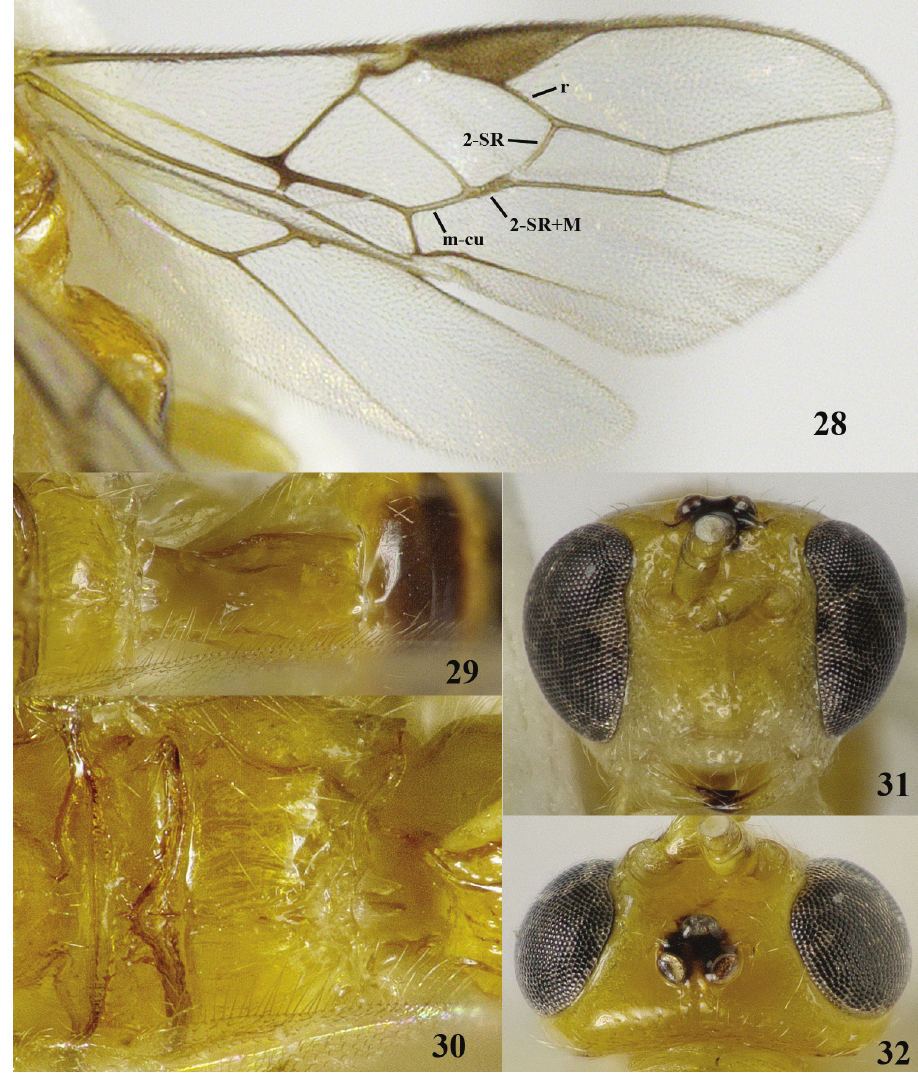
Figs 28–32. Psyttalia incisi (Silvestri), ♂ , China, Fujian. 28 wings 29 first metasomal tergite dorsal 30 propodeum dorsal 31 head anterior 32 head dorsal.